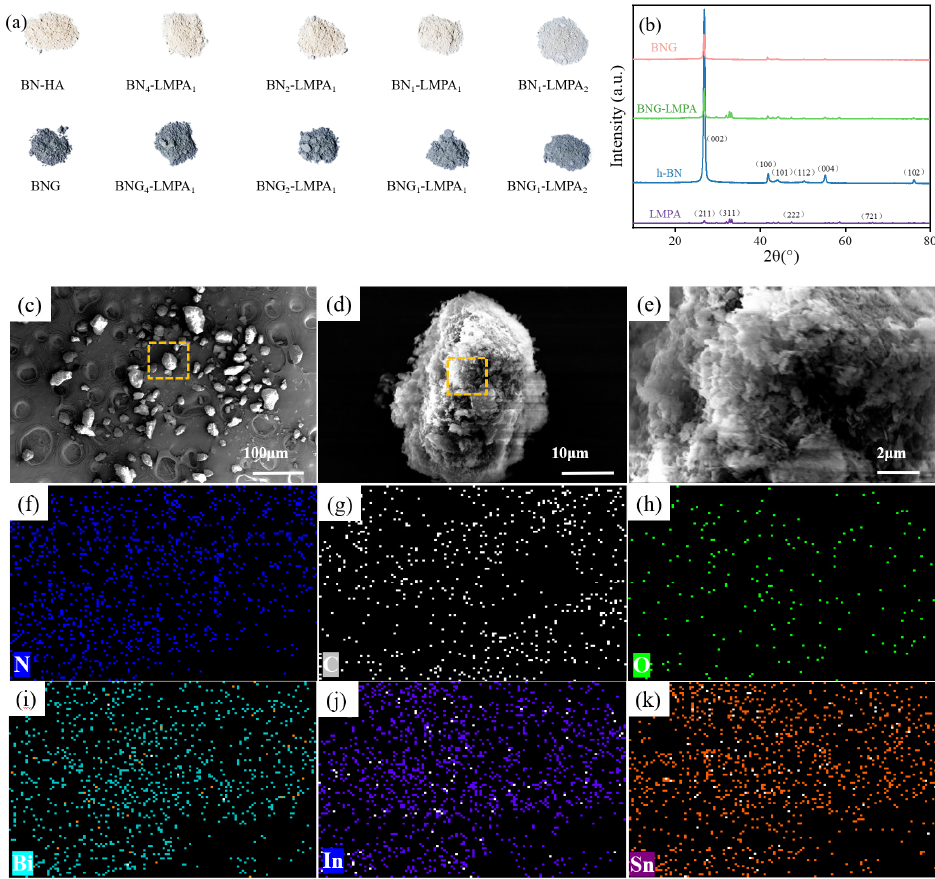
Figure 2. ( a ) Photo of BN-LMPA and BNG-LMPA; ( b ) XRD spectra of h-BN, BNG, LMPA, and BNG- LMPA; ( c – e ) SEM morphology of BNG 1 LMPA 2 and its elemental analysis: ( f – k ) N, C, O, Bi, In, and Sn.